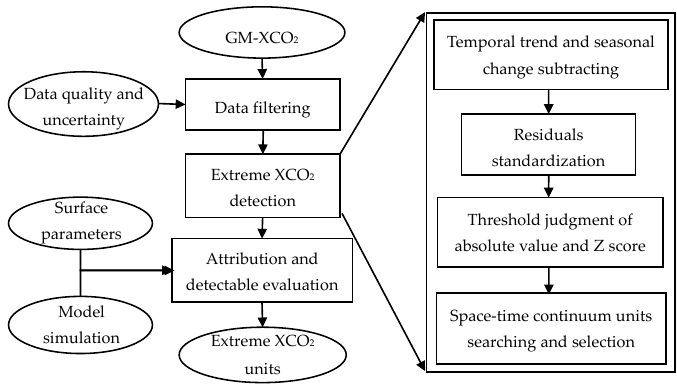
Figure 1. Flowchart showing the basic steps for the end-to-end extreme XCO 2 detection and evaluation.